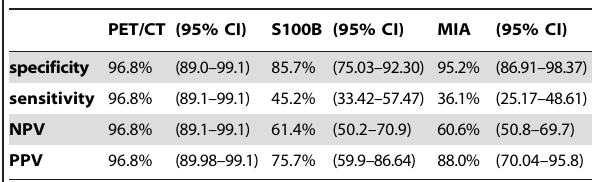
Table 3. Melanoma